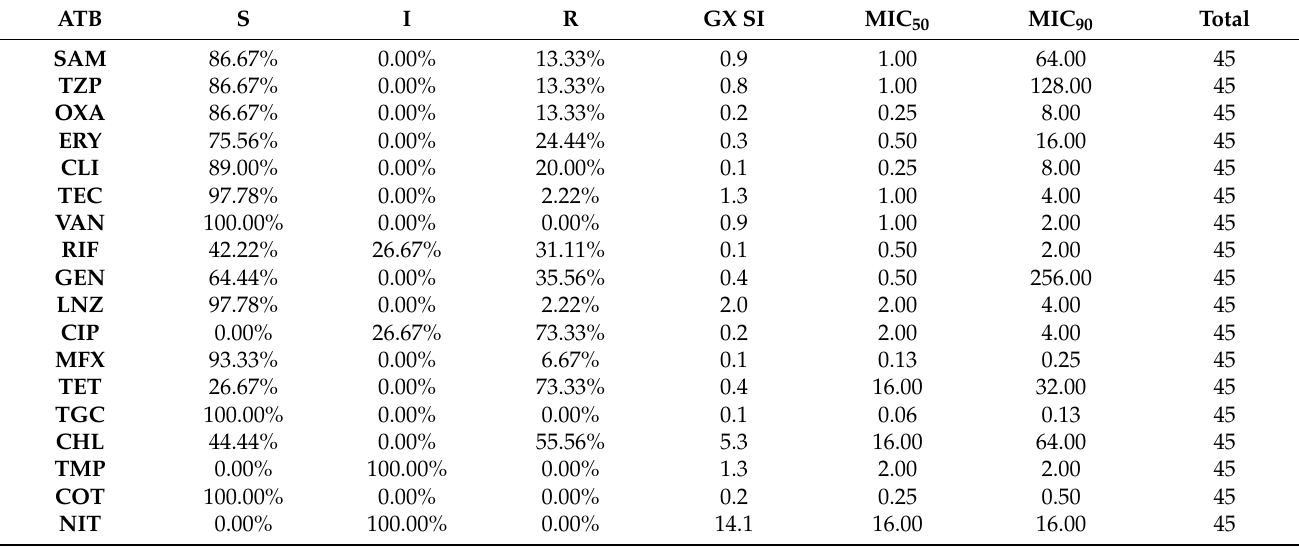
Table 3. Percentage of antimicrobial